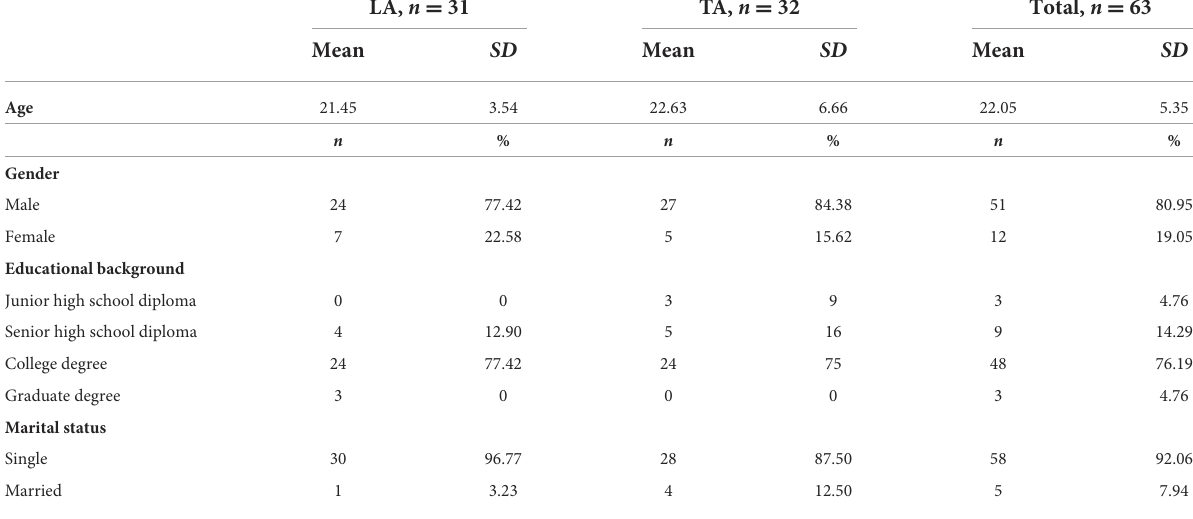
TABLE 1 Between-group differences regarding demographic